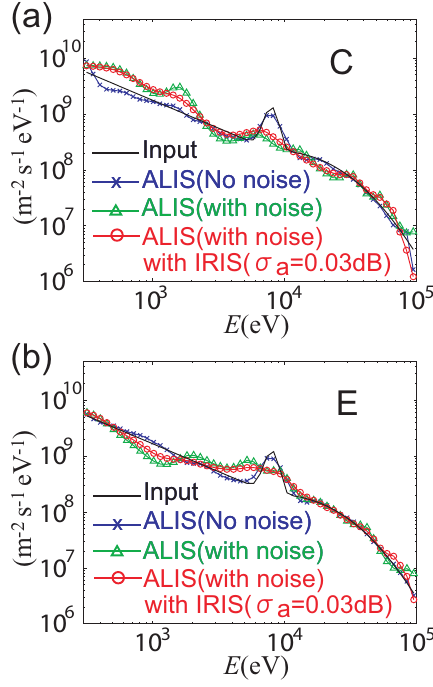
Fig. 10. (a) The differential flux of incident electrons at points C and E in Fig. 3a reconstructed from the images only (green curve) and from both the auroral images and CNA (red curve). The format of this figure is similar to that of Fig.